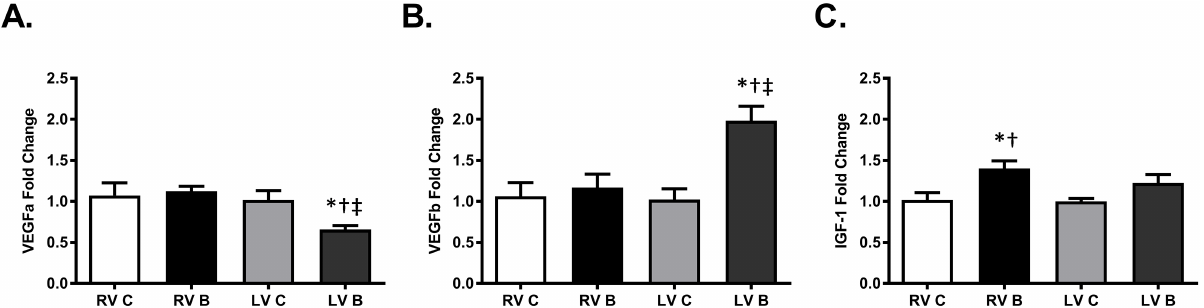
Fig 6. VEGF and IGF-1 gene expression post-burn. PCR measurement of VEGF-A (A), VEGF-B (B), and IGF1 (C) mRNA expressionin right and left ventricles, seven days post-burn. Controls were nonburnedanimals. Data are expressed as the mean ± SEM. Statistical analysiswas performed using a one-way ANOVA. n = 6–9; RV C: right ventricle control; RV B: right ventricleburned; LV C: left ventricle control; LV B: left ventricleburned; VEGF, vascular endothelial growth factor; IGF1, insulin-likegrowth factor 1; * , p < 0.05vs LV C; †, p < 0.05 vs RV C; ‡, p < 0.05vs RV